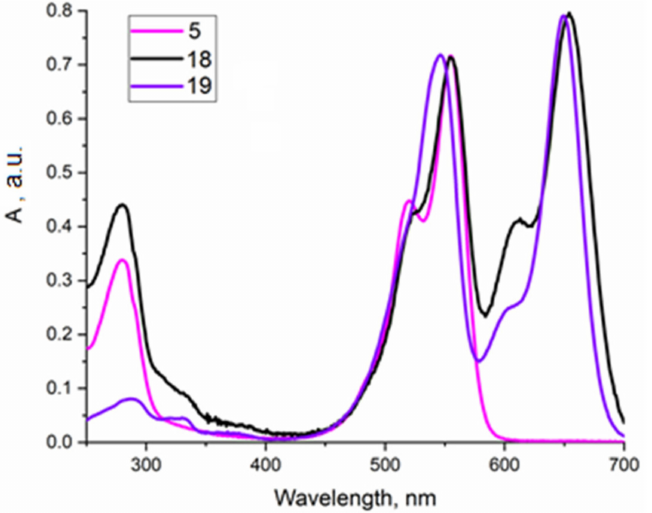
Figure 2. UV/Vis absorbance spectra of 5 and 18 compared to sCy3-sCy5 conjugate 19 in aqueous